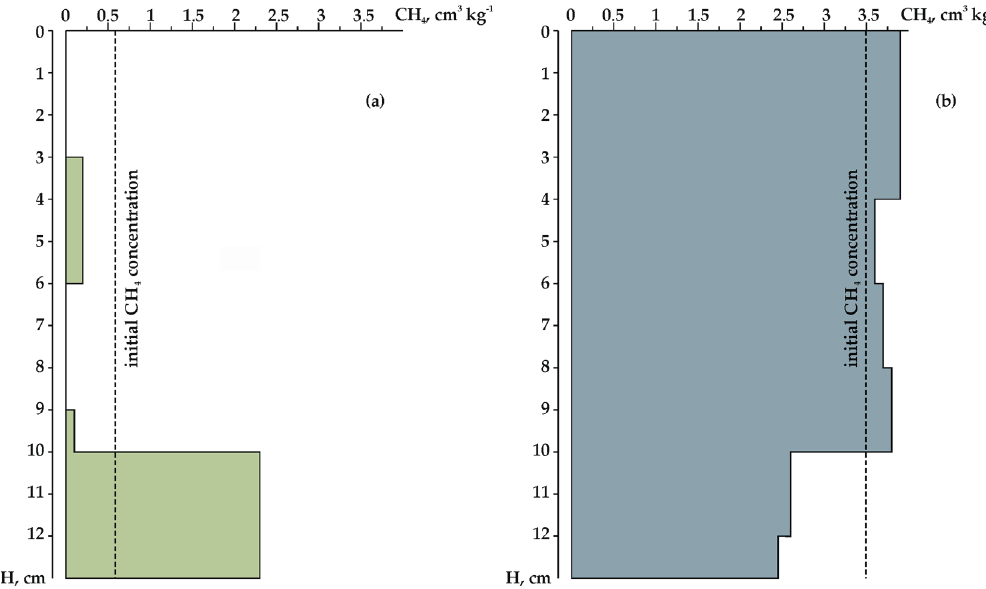
Figure 4. Methane concentration patterns in sand ( a ) and silt ( b ) after the freezing of unsaturated (moisture content 30%) methane-enriched soils.